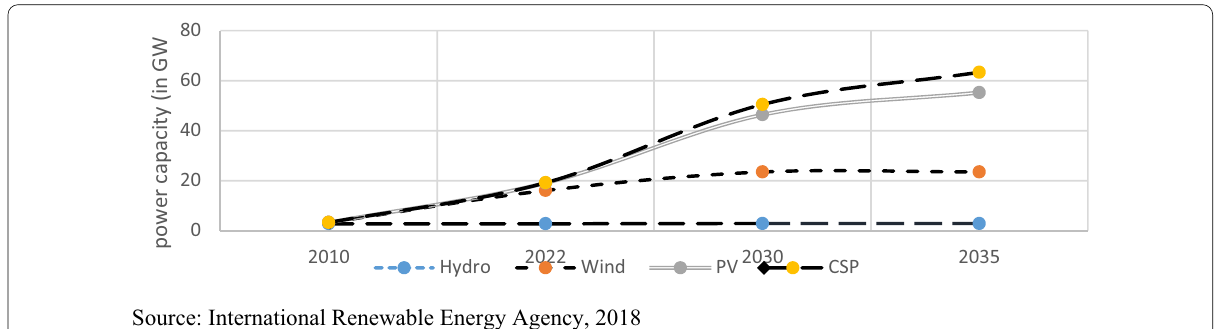
Fig. 1 Current and potential installed capacity of renewable energy in Egypt in Gigawatts. Source : International Renewable Energy Agency [7]